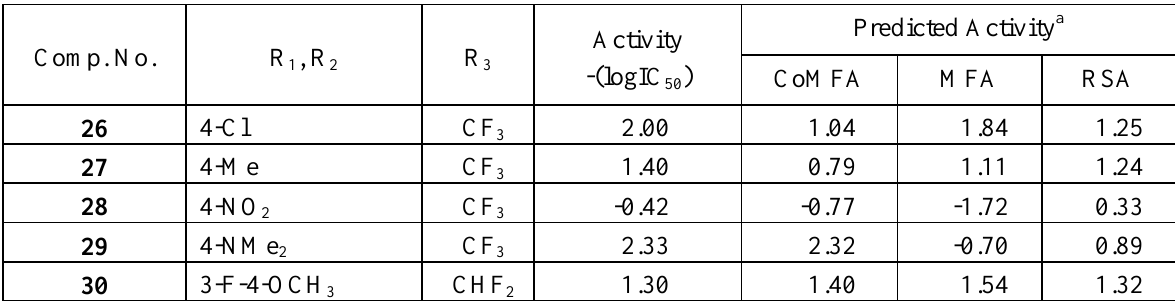
used in the test set.